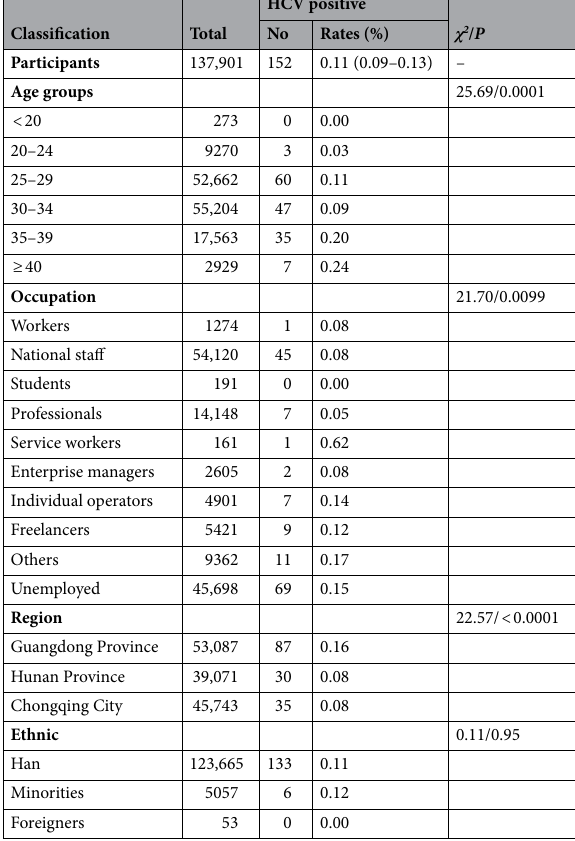
Table 1. HCV antibody positive rate of pregnant